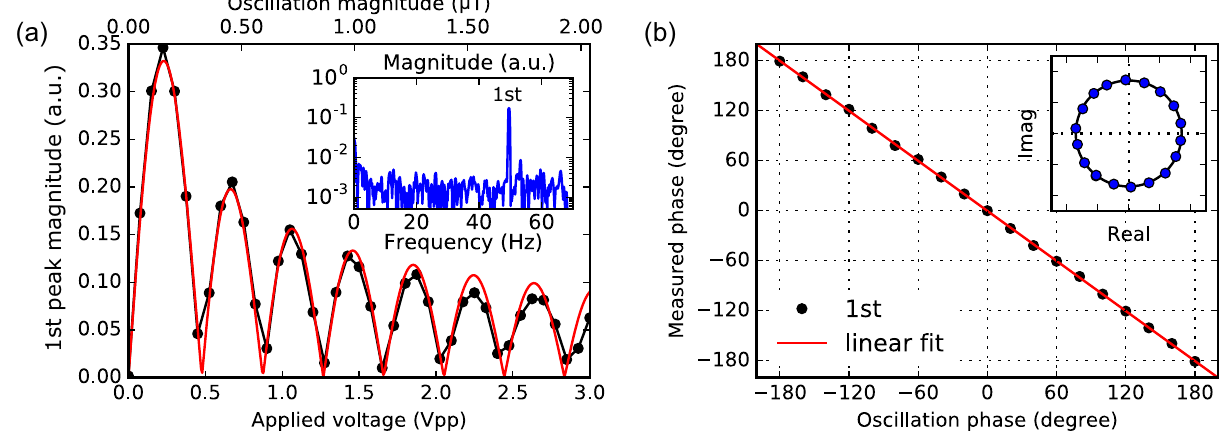
Figure 2. The response of iQdyne-based measurement for an oscillating magnetic field. ( a ) The magnitude of the NV center fluorescence of the first peak (black dots) obeys the first-kind Bessel function (red) with the oscillation field strength. Inset: a measured spectrum with b z = 51nT . ( b ) The measured phase of the first peak corresponds one-to-one to the oscillation phase, with an experimental condition b z = 51nT . Inset: plotted on an IQ diagram.